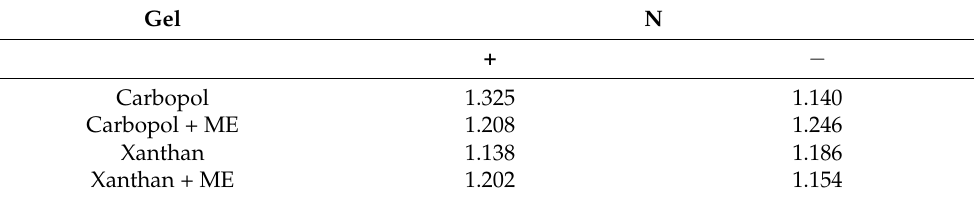
Figure 3. Rheogram for Xanthan gel, ME-containing Xanthan gel, and Xanthan gel after 6 months; (+) up-curve, ( − ) down-curve. Table 3. Farrow’s constants (n). Table 3. Farrow’s constants